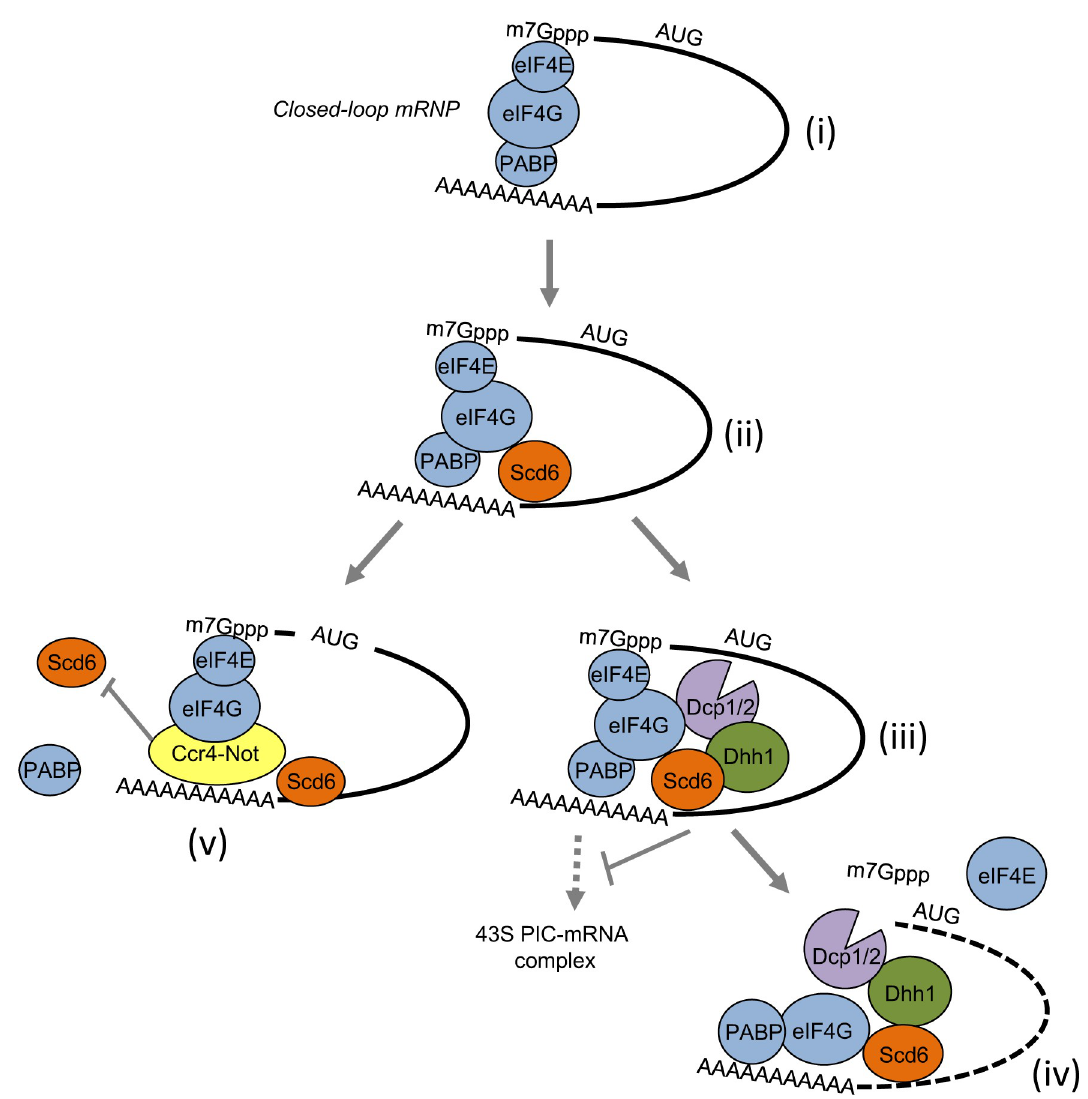
Fig 9. Model for Scd6-stimulated translational repression via Dhh1 and mRNA decapping by Dcp1/Dcp2, perturbed by the Ccr4/Not complex. (i) Closed-loop mRNP formation by mutual interactions of eIF4G with eIF4E bound to the mRNA cap and PABP bound to the poly(A) tail of mRNA, activating mRNA for translation initiation. (ii) Scd6 is recruited to the mRNA by binding to the C-terminus of eIF4G, but might also interact independently with the 3’UTR. (iii) Scd6 recruits Dhh1 and Dcp1/Dcp2 to form an inactive mRNP incapable of recruiting the 43S PIC complex near the 5’ end of the mRNA. (iv) Dcp1/Dcp2 decaps the mRNA, dissociating eIF4E, and exposing the 5’ end of the mRNA for subsequent exonucleolytic degradation (depicted as dotted line). (v) Recruitment of the Ccr4/Not complex to the mRNA interferes with Scd6-mediated translational repression and mRNA